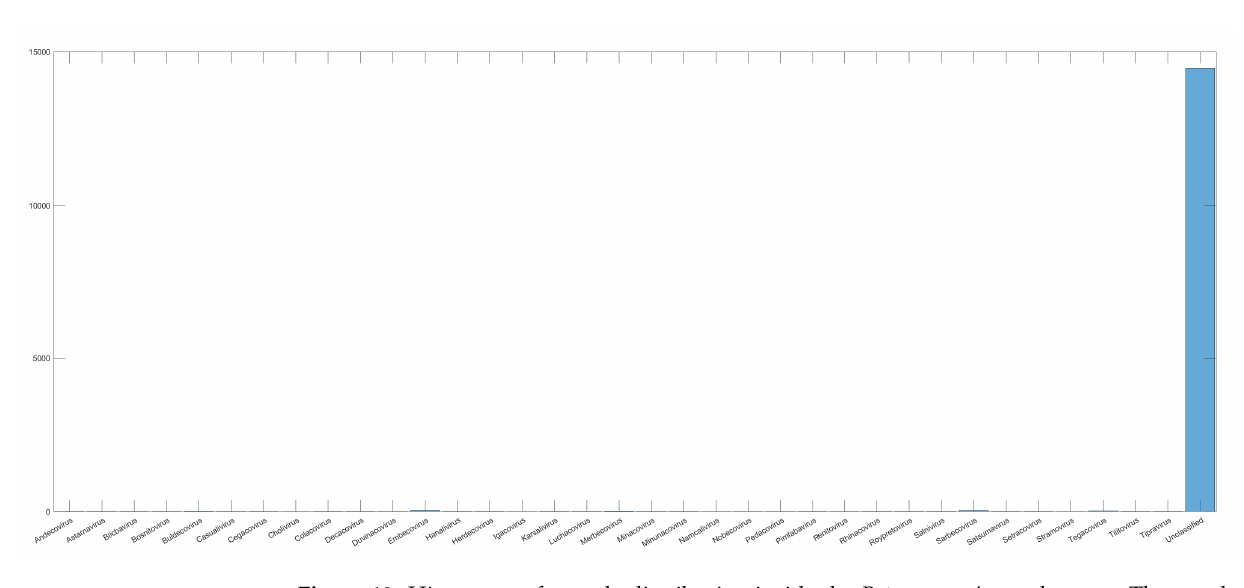
Figure 10. Histogram of sample distribution inside the Betacoronavirus subgenus. The number of samples without classification (Unclassified) is more than 15,000 times bigger than the ones with a defined